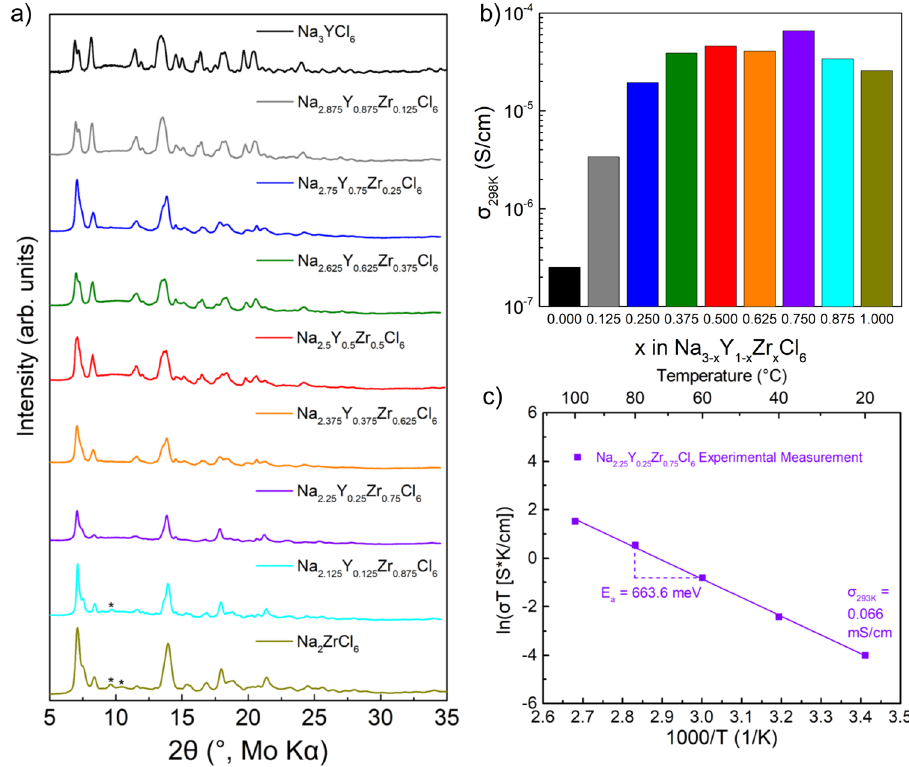
Fig. 2 Experimental Characterization of Na 3- x Y 1- x Zr x Cl 6 . a XRD of the Na 3-x Y 1-x Zr x Cl 6 compositions, obtained in x = 0.125 increments. Asterisks indicate the presence of new peaks. b The corresponding room temperature conductivity values. c Arrhenius plot of Na 2.25 Y 0.25 Zr 0.75 Cl 6 from experimental measurements. The activation energy (low-temperature regime) and room temperature conductivity values are consistent with the MTP